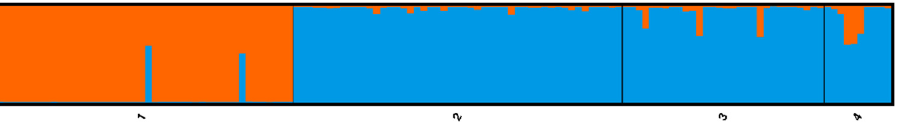
Figure 2. Inferred ancestry under K = 2 genetic clusters using STRUCTURE analyses. The orange cluster (1) includes the National Champion tree and its progeny; the blue cluster are the remaining trees and includes the Ohio State Champion and its progeny (2) and the naturally growing trees in Ohio (3) and Illinois (4).